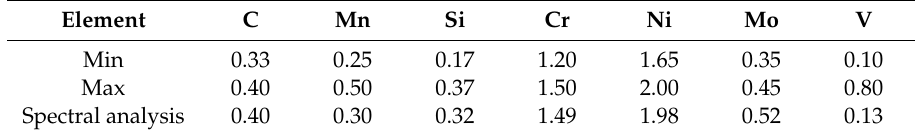
Table 1. Chemical composition of the AISI 4340 examined steel (wt.%).